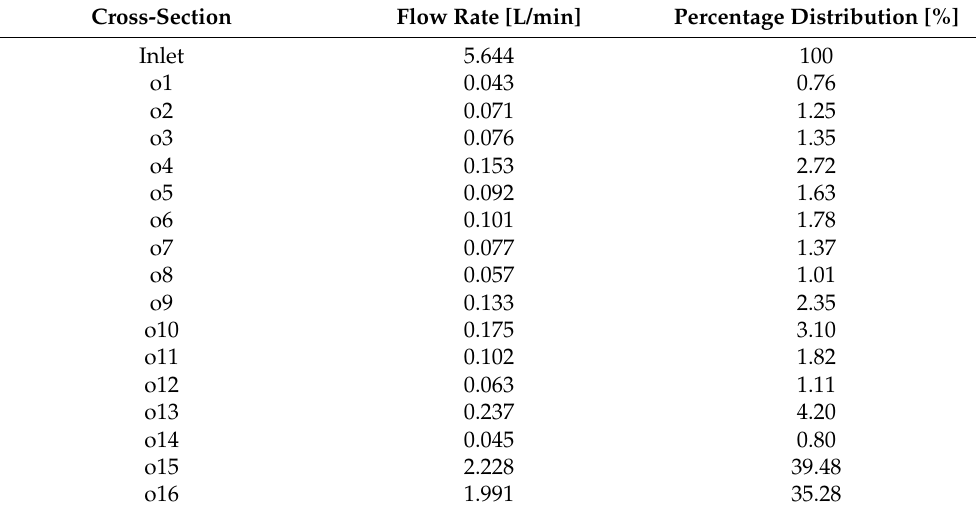
Table 3. Flow distribution in the abdominal aorta and the side branches.